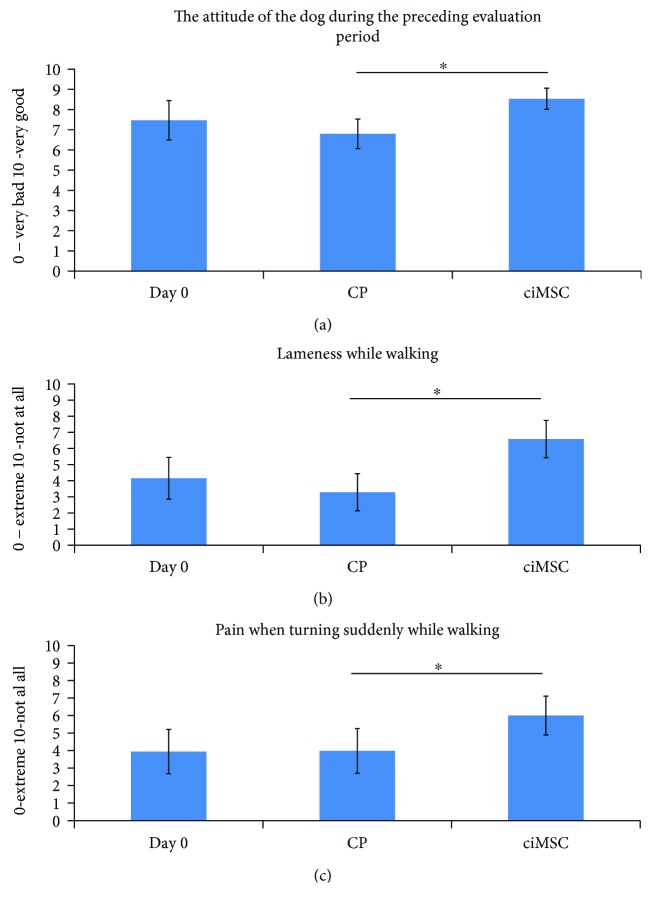
Mean scores (±standard error of the mean) of three questions of the owner survey based on the study of Hudson et al. [26] at baseline (day 0), after placebo control product (CP) administration (week 6) and after xenogeneic chondrogenic induced mesenchymal stem cell (ciMSC) administration (week 12). The asterisk (∗) indicates a significant difference in mean scores between the two treatment groups (P < 0.05).